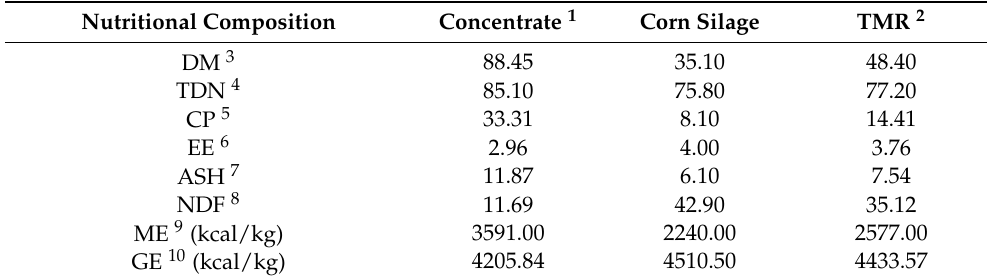
Table 1. Nutritional composition (dry matter basis, % unless otherwise noted) of concentrate, corn silage and total mixed ration offered to heifers during trial